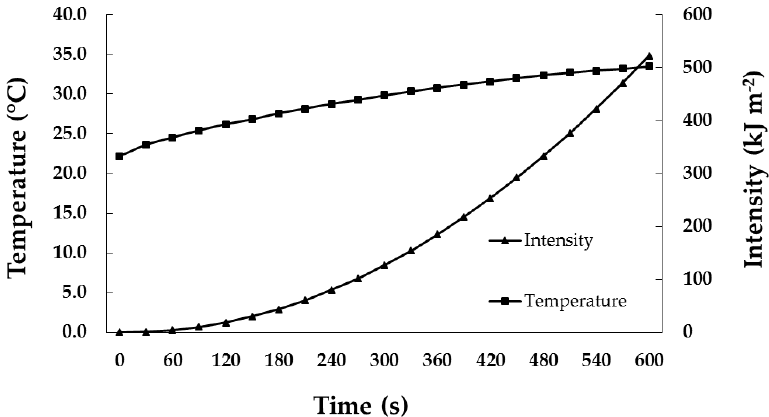
Figure 1. UV-C (ultraviolet C) intensity and temperature overtime.